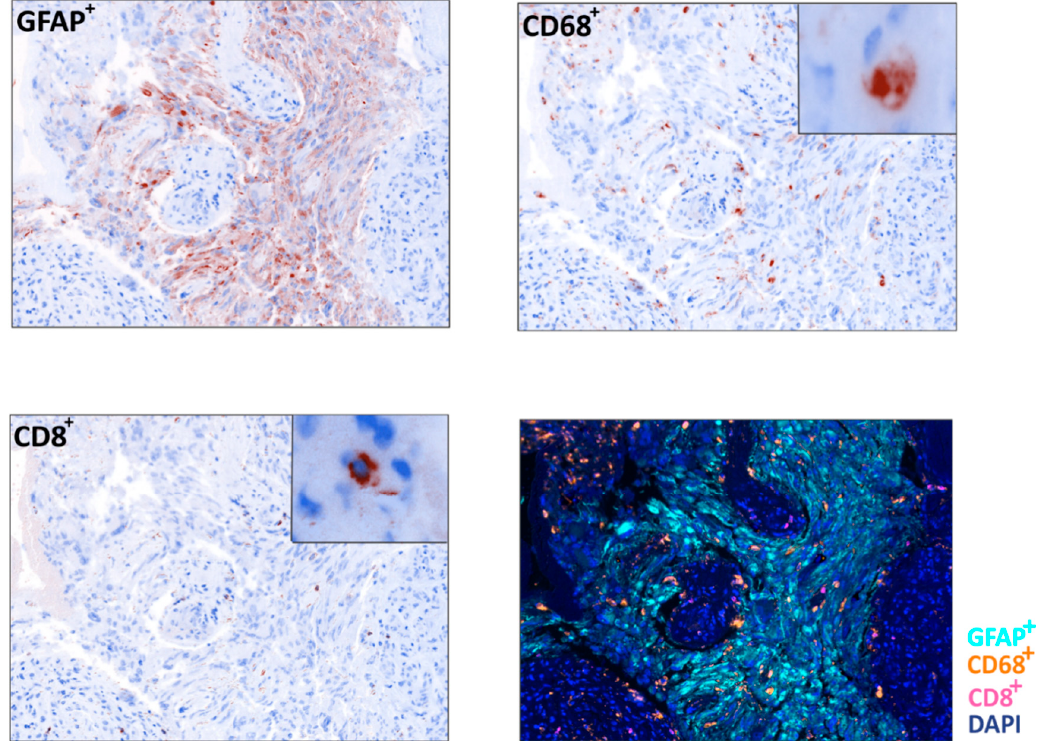
Figure 4. Immune infiltrate analysis in a glioblastoma sample. Representative example of a Multispectral Imaging field obtained from a glioblastoma sample in which the markers GFAP (light blue), CD68 (orange) and CD8 (pink) are reported (20× zoom, lower right panel) and relative pseudo-immunohistochemistry representations of the single cell populations (40 × zoom). DAPI (blue) was used as nuclear